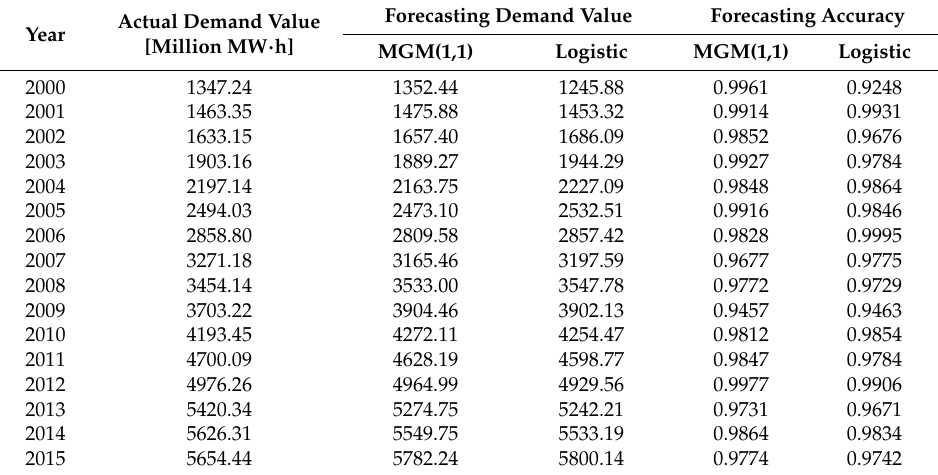
Table 2. Single forecasting results.